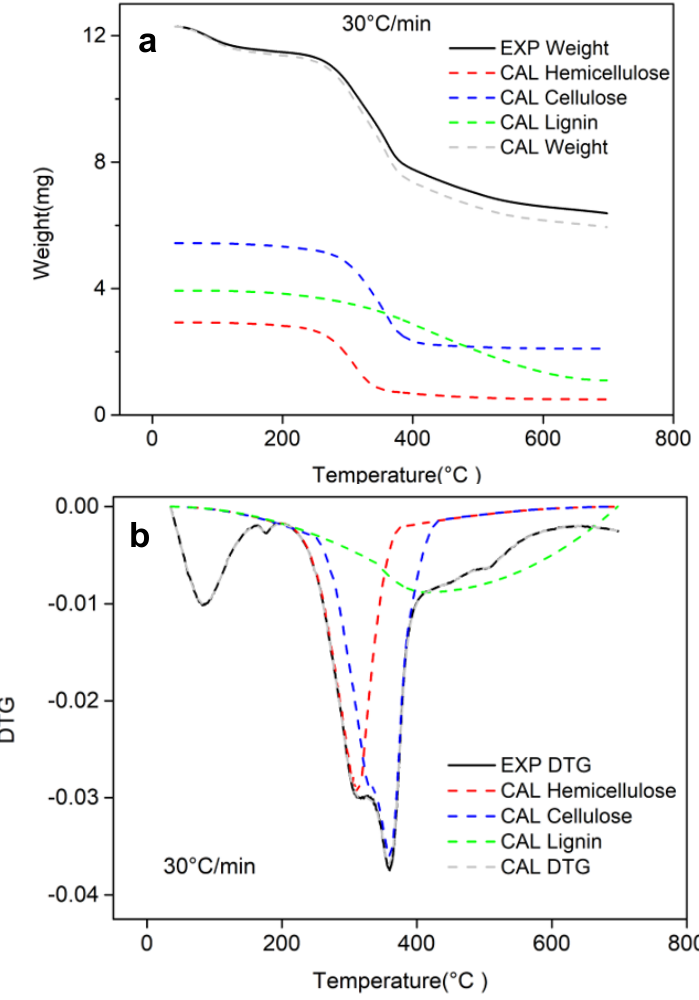
Figure 8. Calculated ( a ) TG and ( b ) DTG curves based on the optimized parameters compared with experimental data at 30 °C/min.